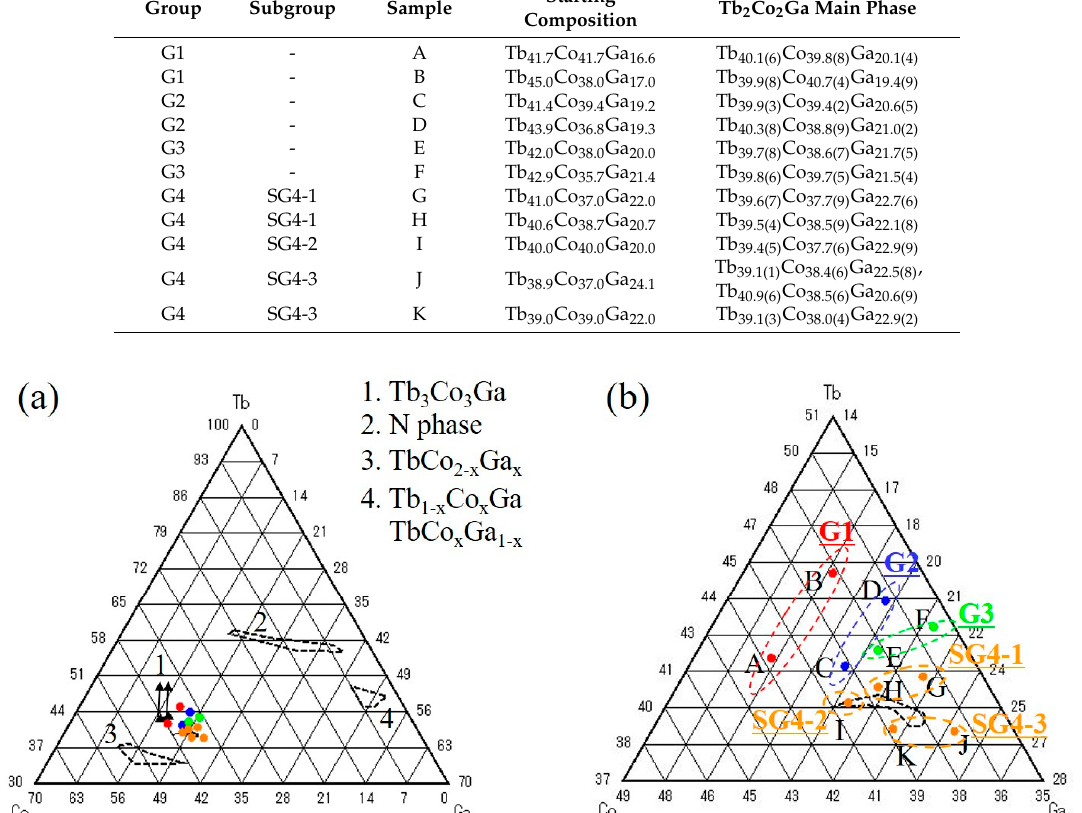
Figure 2. ( a ) Ternary phase diagram of the Tb–Co–Ga system for prepared samples plotted based on their starting compositions (filled colored circles). The impurity phases (Tb 3 Co 3 Ga, the N phase, TbCo 2 − x Ga x , Tb 1 − x Co x Ga and TbCo x Ga 1 − x ) are also added. The area surrounded by broken lines indicates a range of the solid solution detected by EDX measurement. The homogeneity range of Tb 3 Co 3 Ga is depicted by the black triangles. ( b ) Expanded diagram around the Tb 2 Co 2 Ga phase. The area surrounded by black broken-lines indicates a range of the solid solution of Tb 2 Co 2 Ga detected by EDX measurement.